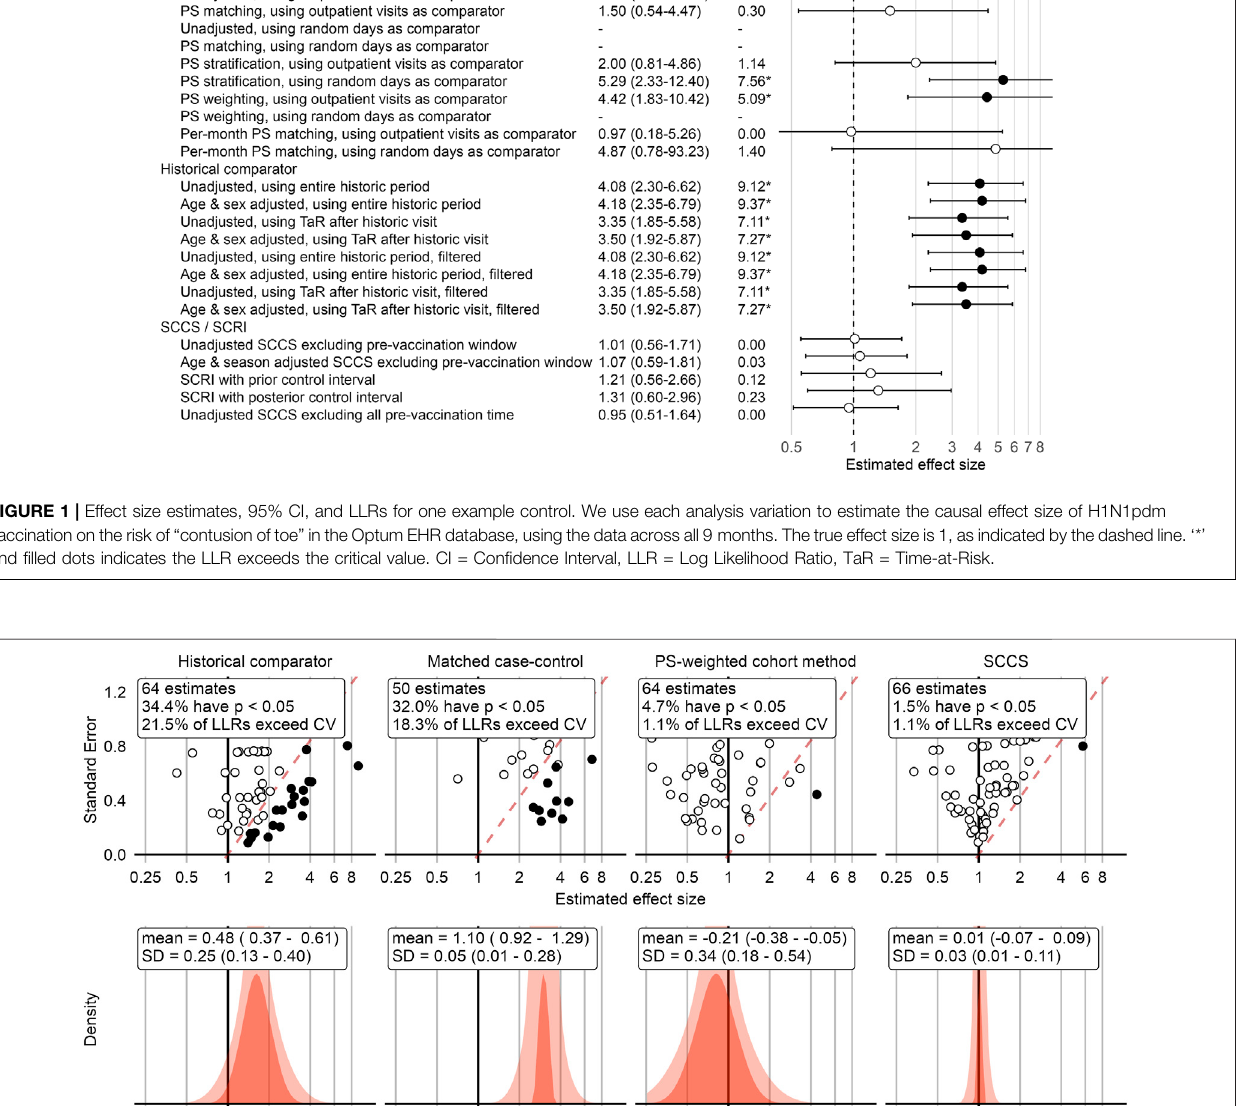
Frontiers in Pharmacology |